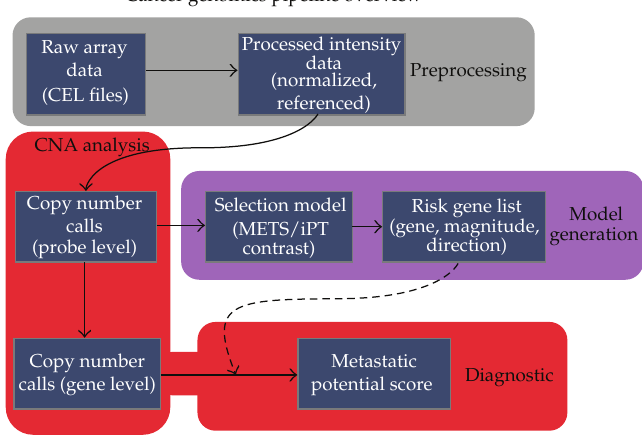
Figure 1: Array CGH analysis pipeline for processing pixel image data from A ff ymetrix SNP arrays to produce genotype and signal intensity measures for copy number analysis used for developing bioclinical models and